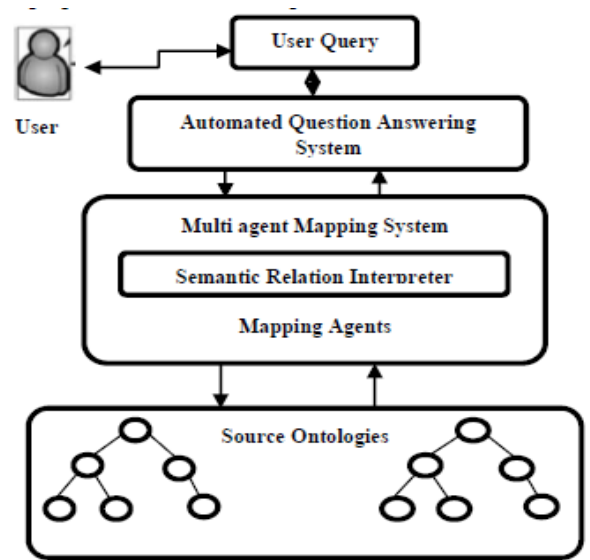
Figure 6. The proposed system for QA system When a number of concept to map deceases multiagent framework decrease response time. To solve the different problems of integration an integrated ontology mapping framework provided. A DSSim solution is a prototype for the proposed system. That combined with automated QA system at the moment. Multiagent system with semantic relation interpreter of with effectively in the multiagent